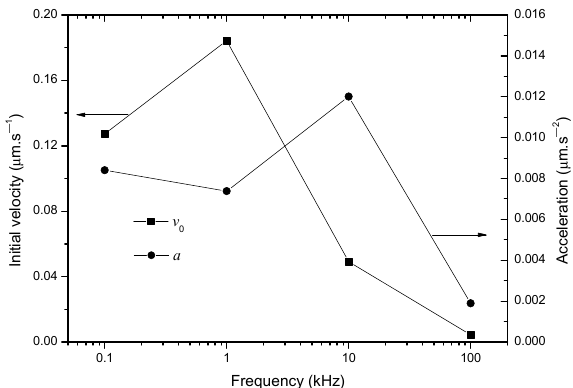
Figure 8. Comparison between the predicted time consumed for motion and the experimental time under di ff erent frequencies.